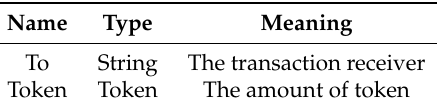
Table 4. Data structure of